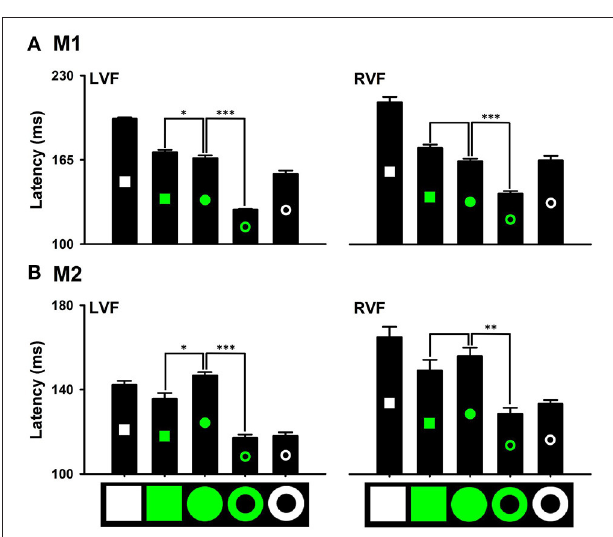
FIGURE 7 | Effects of distinctions in the global and local features on detecting the distinction in red color (A) , M1; (B) , M2. * P < 0.05; ** P < 0.01; *** P < 0.001.